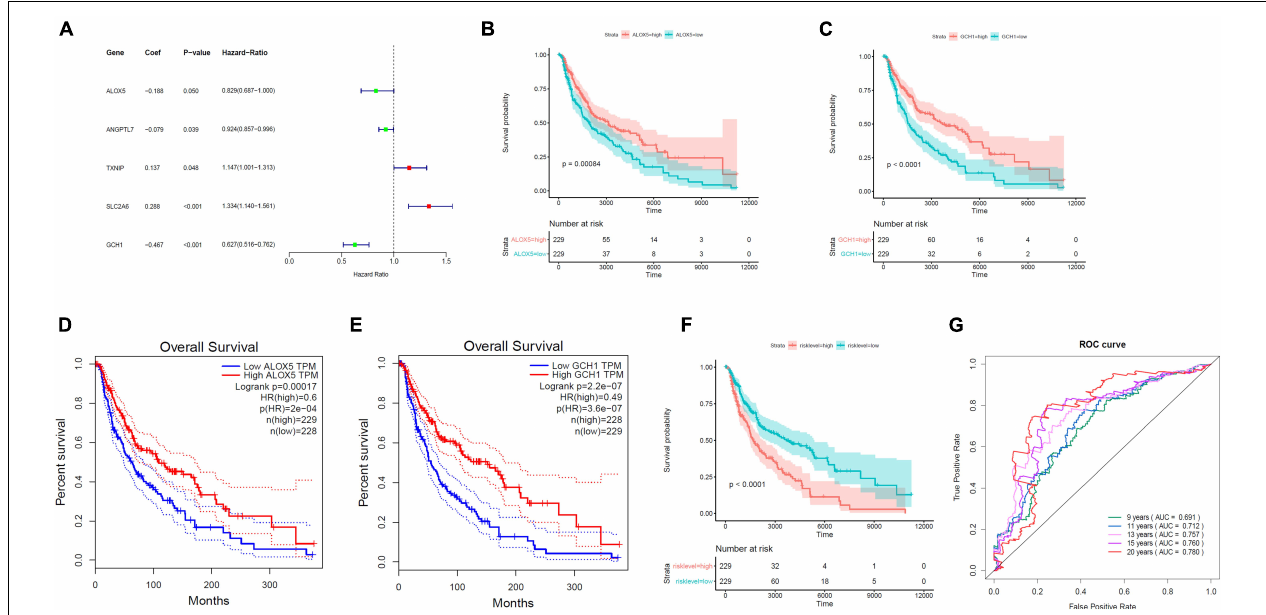
FIGURE 3 | Establishment of the ferroptosis-linked gene predictive model. (A) The forest plots of hazard ratios showed the risk and protective factors; protective factors are indicated in green, and risk factors are indicated in red. (B,C) Kaplan–Meier survival curves of ALOX5 and GCH1 in the prognosis of melanoma patients. Patients with low ALOX5 and GCH1 expression exhibited a shorter overall survival rate (ALOX5, p = 0.00084; GCH1, p < 0.0001). (D,E) Overall survival analysis in high and low ALOX5 and GCH1 expression samples in the GEPIA data resource. (F) Kaplan–Meier survival curve of TCGA samples stratified into high- and low-risk groups in the entire set ( p < 0.0001). (G) The ROC curves for 9-, 11-, 13-, 15-, and 20-year overall survival predictions.